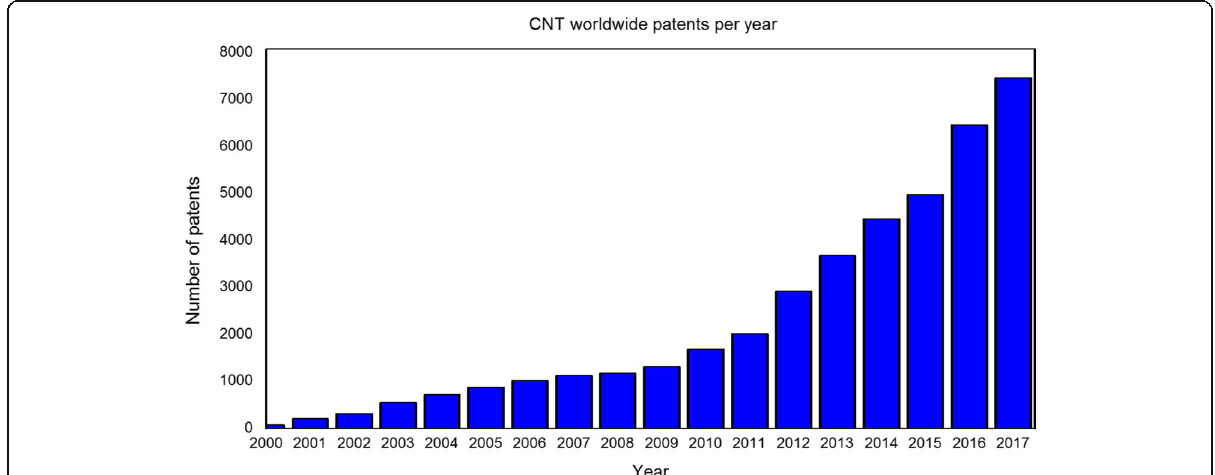
Fig. 47 Trends in CNT-related patents filed worldwide between 2000 and 2017. Data collected from European Patent Office ’ s webpage using keywords ‘ carbon nanotubes or carbon nanotube or graphene